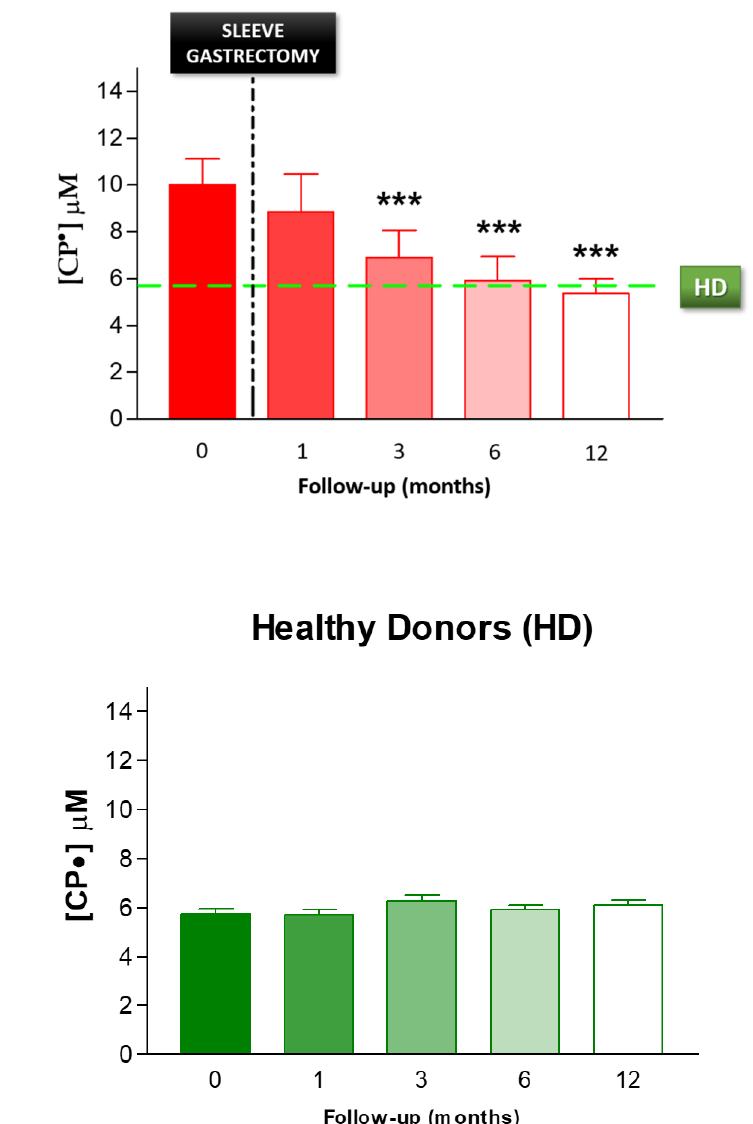
Figure 6. ( A ) EPR-spin probing analysis of oxidative stress in patients’ blood before (0) and after SG. The green line represents the mean value of the CP • concentration detected in the control group HD, *** p < 0.01. ( B ) EPR- spin probing analysis of oxidative stress in the control population (HD), no